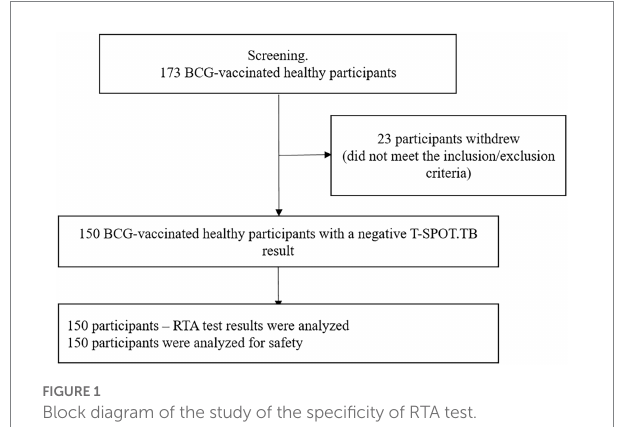
FIGURE 1 Block diagram of the study of the specificity of RTA test.